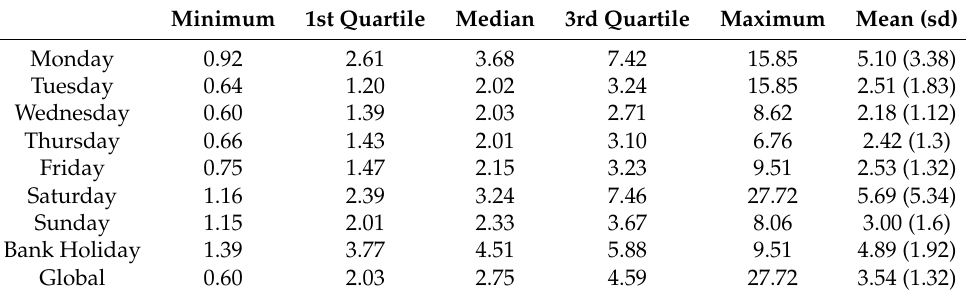
Table 11. Daily MAPE (%) for model (9).